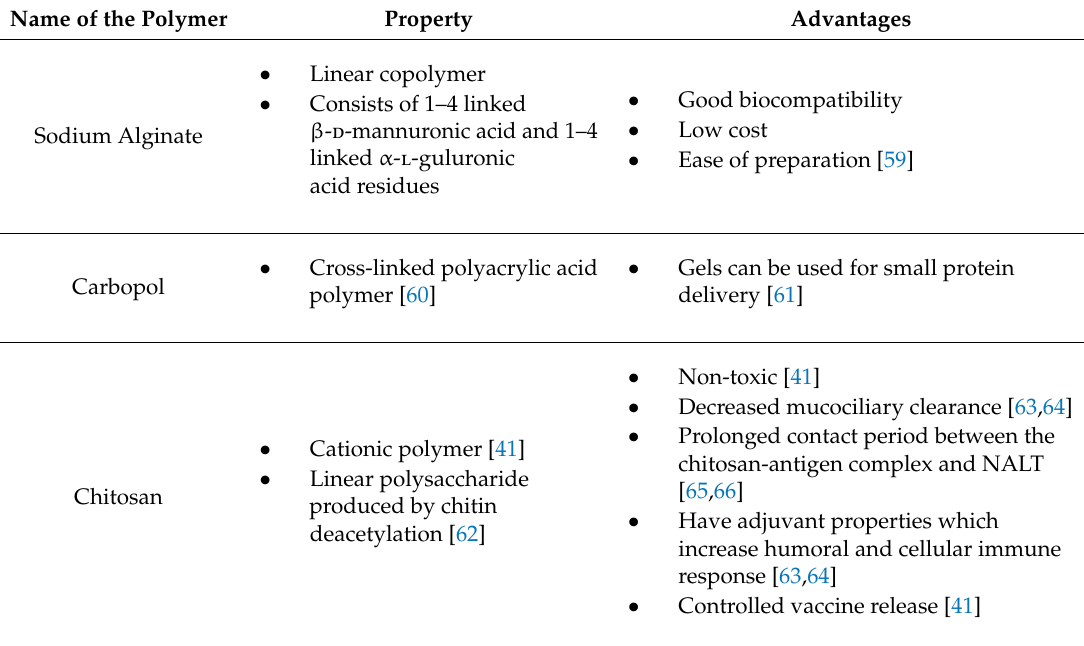
Table 1. Comparative studies among di ff erent polymers used for mucoadhesives intranasal solid vaccine